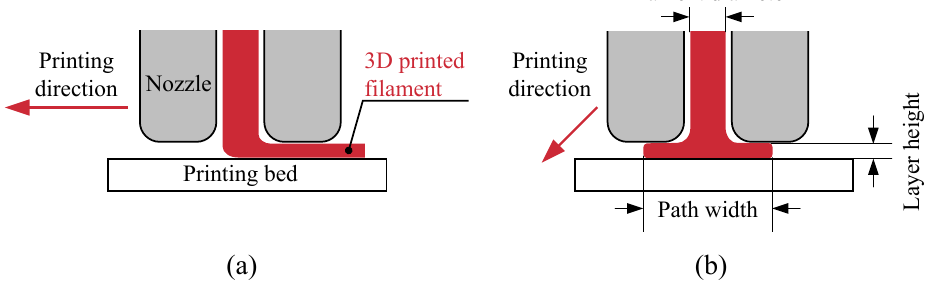
Figure 1. Illustrations of the CFF 3D printing. Schematic representation of the printing process in the print head in ( a ) front view and ( b ) lateral